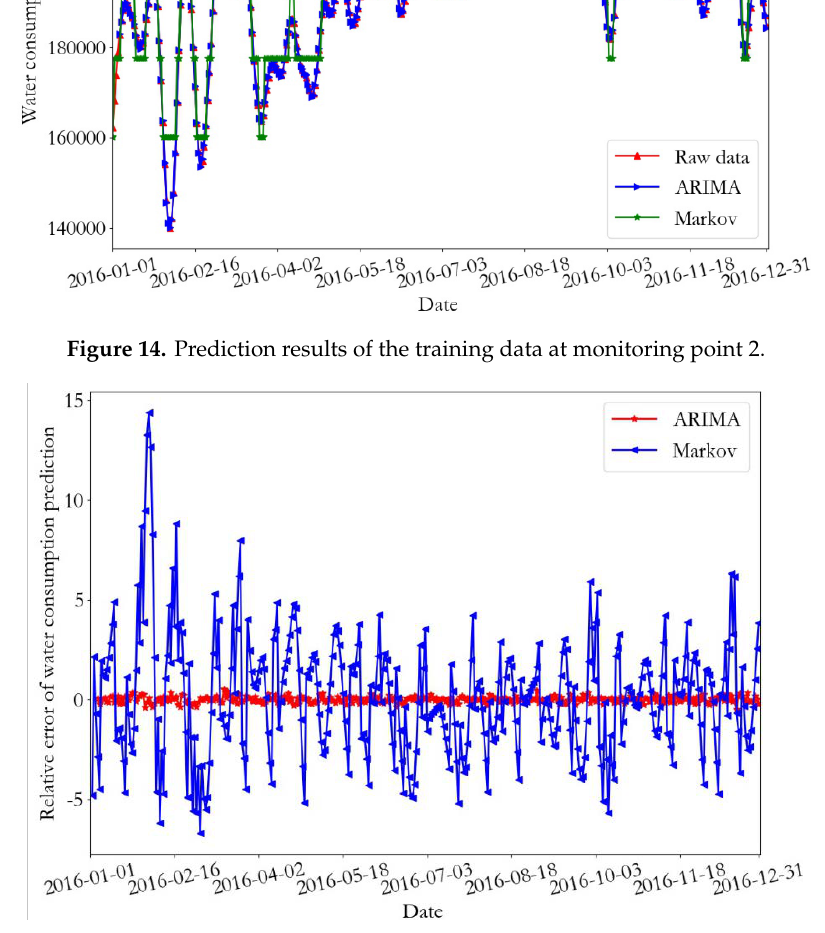
Figure 15. The relative error of the training data at monitoring point 2.